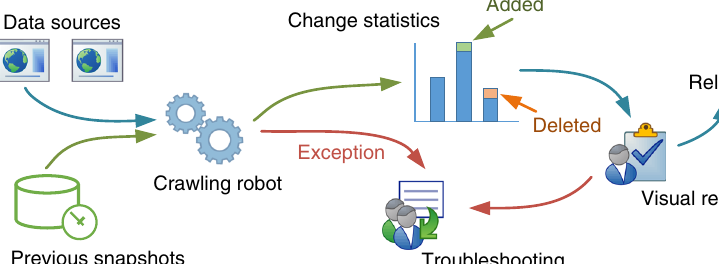
Fig. 4 Schematic diagram of the semi-automatic data synchronization work fl ow